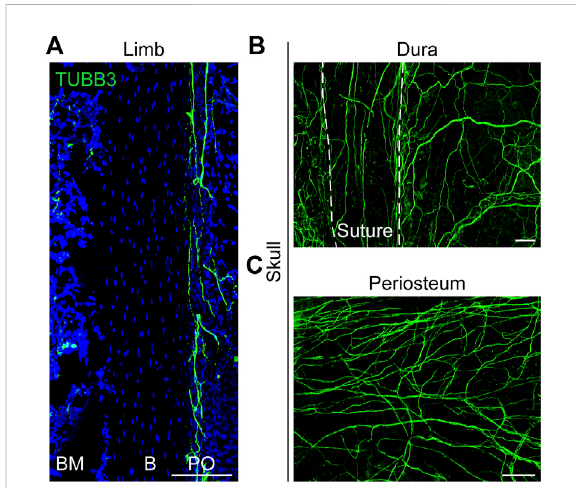
FIGURE 1 Distribution of nerves in limb and skull. (A) Pan-neuronal tubulin beta 3 Class III (TUBB3) whole-mount immunohistochemical staining ofthe mouse ulnar periosteum. (B, C) Whole-mount images of the mouse calvaria, showing the TUBB3 + nerve fi bers in the (B) dura and (C) periosteum. White dashed lines indicate margins of the interfrontal suture, imaged from the endocranial aspect. B, bone; BM, bone marrow; PO, periosteum. White scale bar, 100 μ